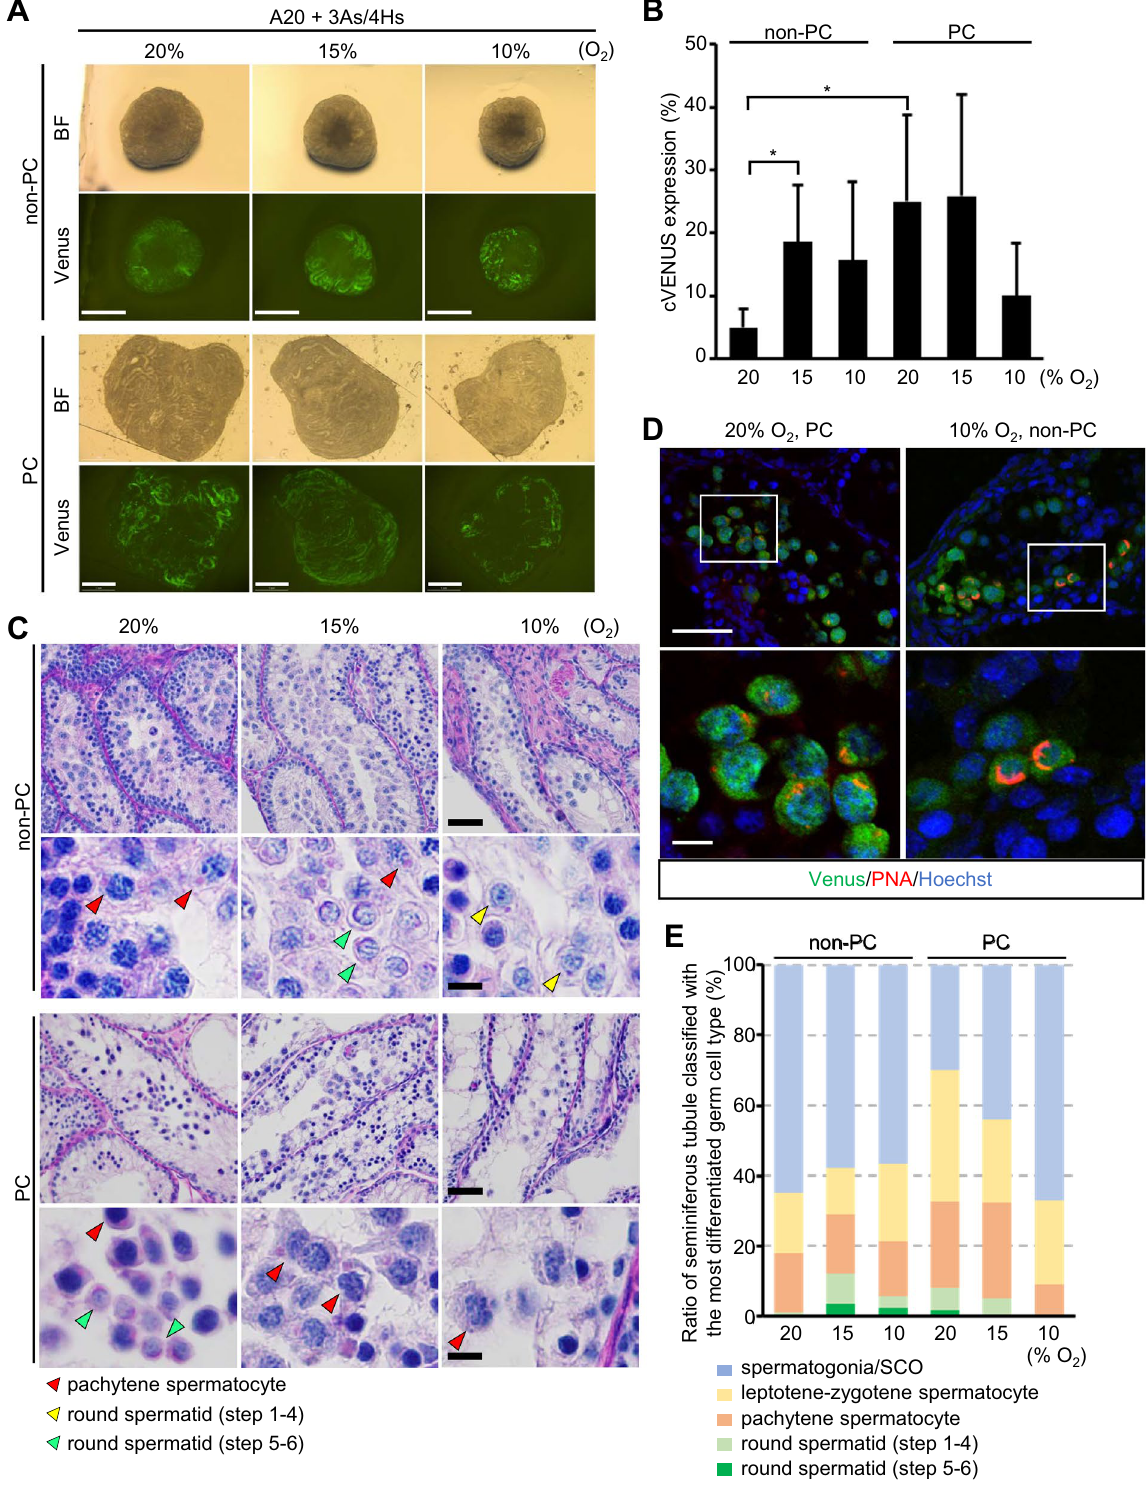
Figure 4. Effect of oxygen concentration for in vitro rat spermatogenesis. ( A ) Photos of cultured testis tissues at week 6 in different O 2 concentrations with or without PC. Scale bar; 1 mm. ( B ) cVenus expression area ratio in each group at week 6. n = 6–7 (P7). * P < 0.05. ( C ) Histological pictures of 6 week cultured tissue stained with PAS. Red, yellow, and green arrowheads indicate pachytene spermatocyte, round spermatids at step 1–4, and step 5–6, respectively. Panels in 2nd and bottom row are magnified image. Scale bar; 50 µm (top and 3rd row), 10 µm (2nd and bottom row). ( D ) Immunohistochemical staining with anti-Venus (green) and PNA (red), along with nuclear stain with Hoechst (blue). Area in white rectangles in top panels was enlarged in bottom panels. Scale bar; 50 µm (top panels), 10 µm (bottom panels). ( E ) Ratio of seminiferous tubules classified with the most differentiated germ cell type contained was shown by band graph. Round spermatids of step 1–4 appears as having acrosome of dot shape, while step 5–6 having cap shape. n = 5–12